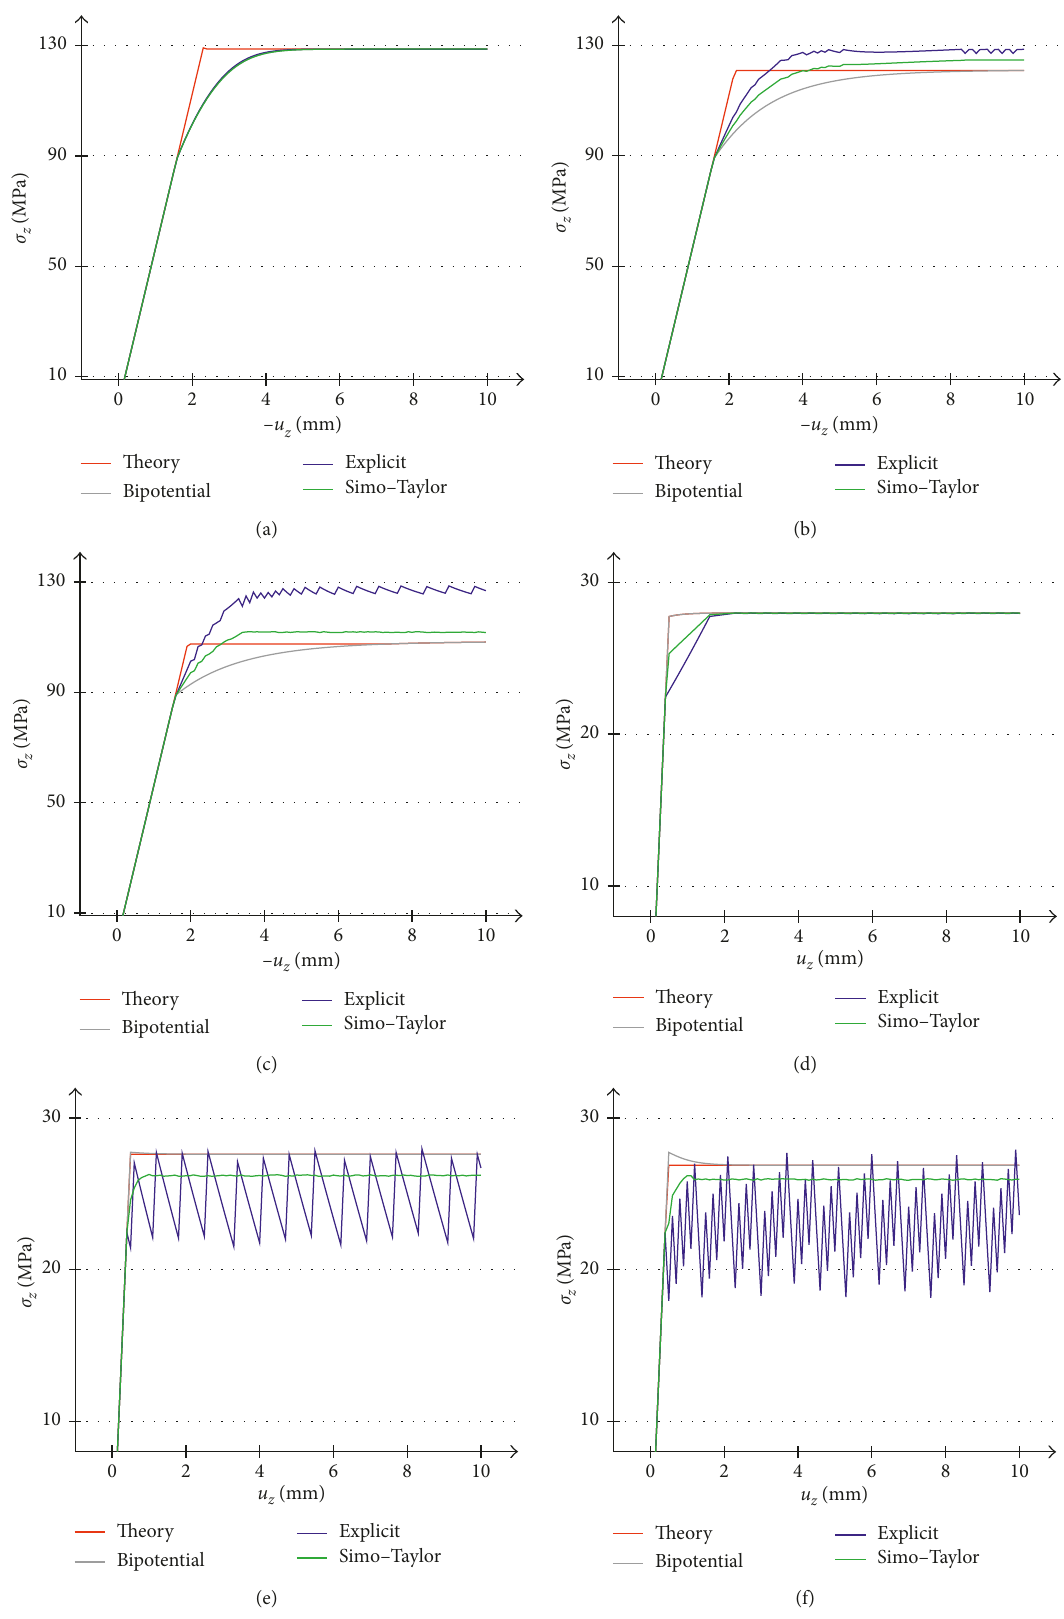
Figure 8: Comparison of different algorithms associated with various dilatancy angles based on stress-displacement curves. Compression at (a) θ 40 ° , (b) θ 20 ° , and (c) θ 20 ° . Tension at (d) θ (cid:31) (cid:31) (cid:31)